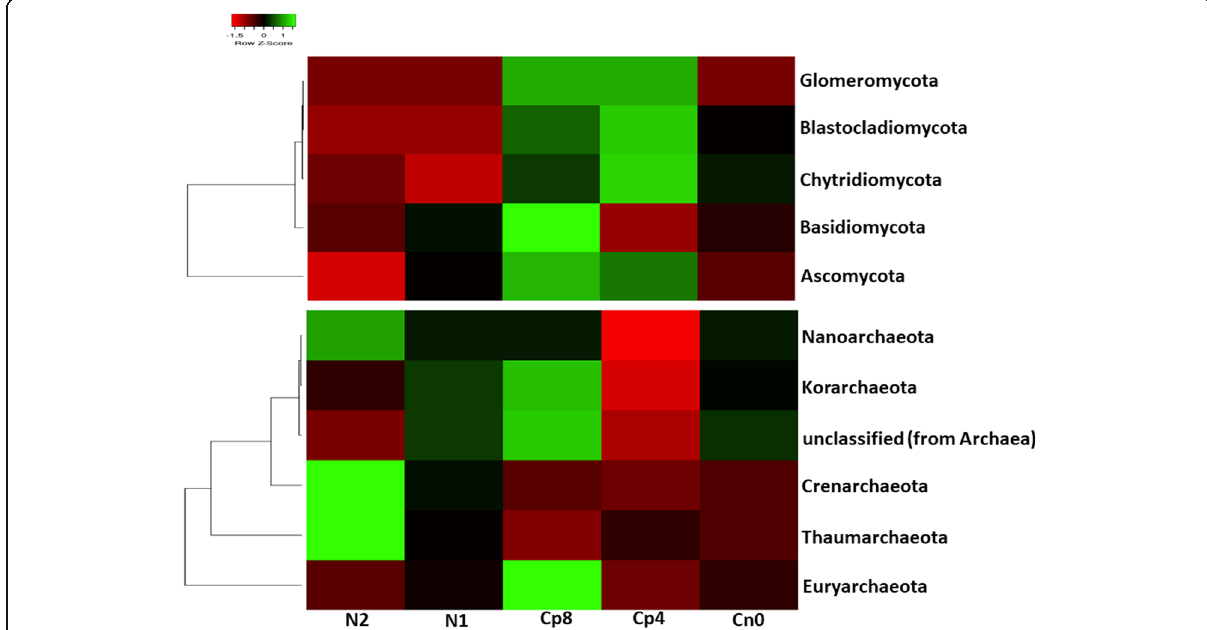
Fig. 5 Heatmap representation of the abundance of fungal and Archaeal community within the treatments from maize rhizosphere samples, Cn0 (control), N1 (60 kg/ha NPK), N2 (120 kg/ha NPK), Cp8 (8 tons/ha compost), and Cp4 (4 tons/ha compost manure)